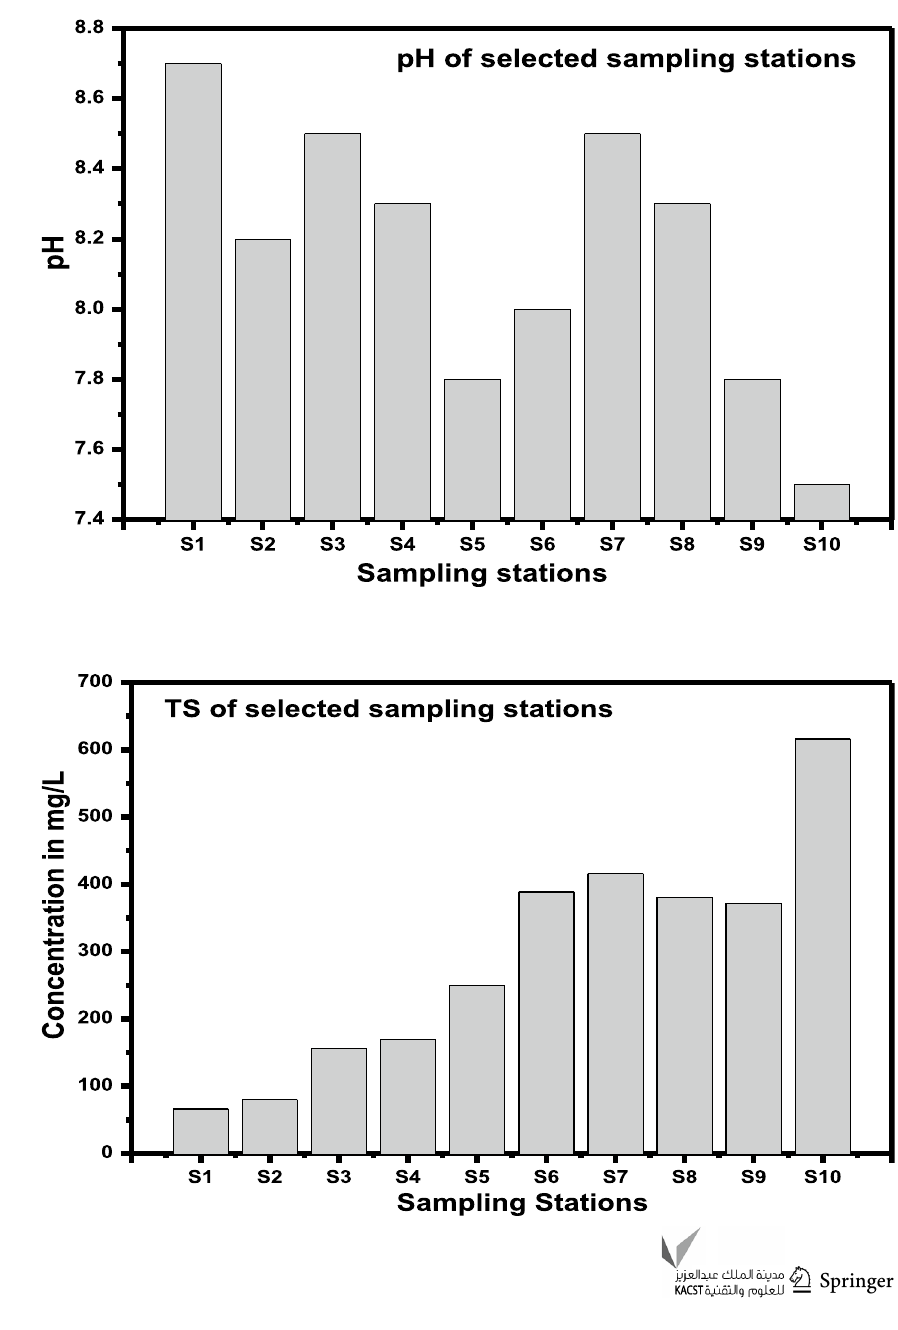
Fig. 2 pH of selected sampling